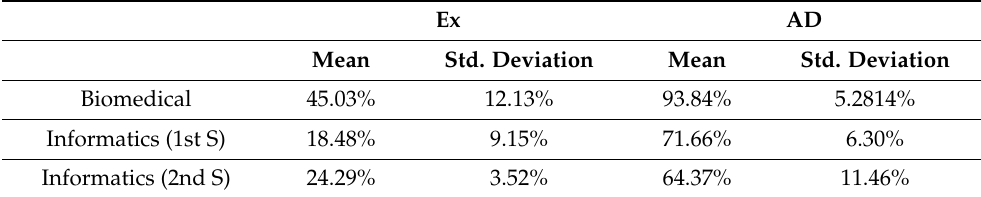
Table 2. Pass rates measures: Ex and